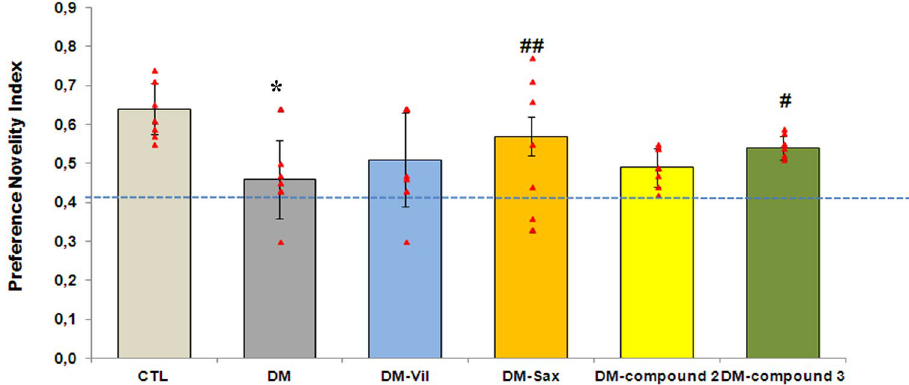
Figure 3. Treatment with novel adamantane derivatives ( 2 , 3 ) or drugs—vildagliptin and saxagliptin attenuates memory impairment in induced diabetic mice in Y Maze Novelty Preference test (NPT). The dotted line at 0.5 indicates the chance performance value. Scores greater than 0.5 indicate a novelty preference. Bars in figure illustrates experimental groups— CTL non-diabetic mice, DM diabetic mice, DM‑Vil vildagliptin-treated mice [20 mg/kg, po ], DM‑Sax saxagliptin-treated mice [10 mg/kg, po ], DM‑compound 2 compound 2-treated mice [50 mg/kg, po ], DM‑compound 3 compound 3-treated mice [50 mg/kg, po ]; respectively. Each column represent means ± SD (n = 8). One-way ANOVA, followed by Tukey’s post hoc test was used. * p < 0.05 as compared with healthy control group. # p < 0.05; ## p < 0.01 compared with diabetic mice group.